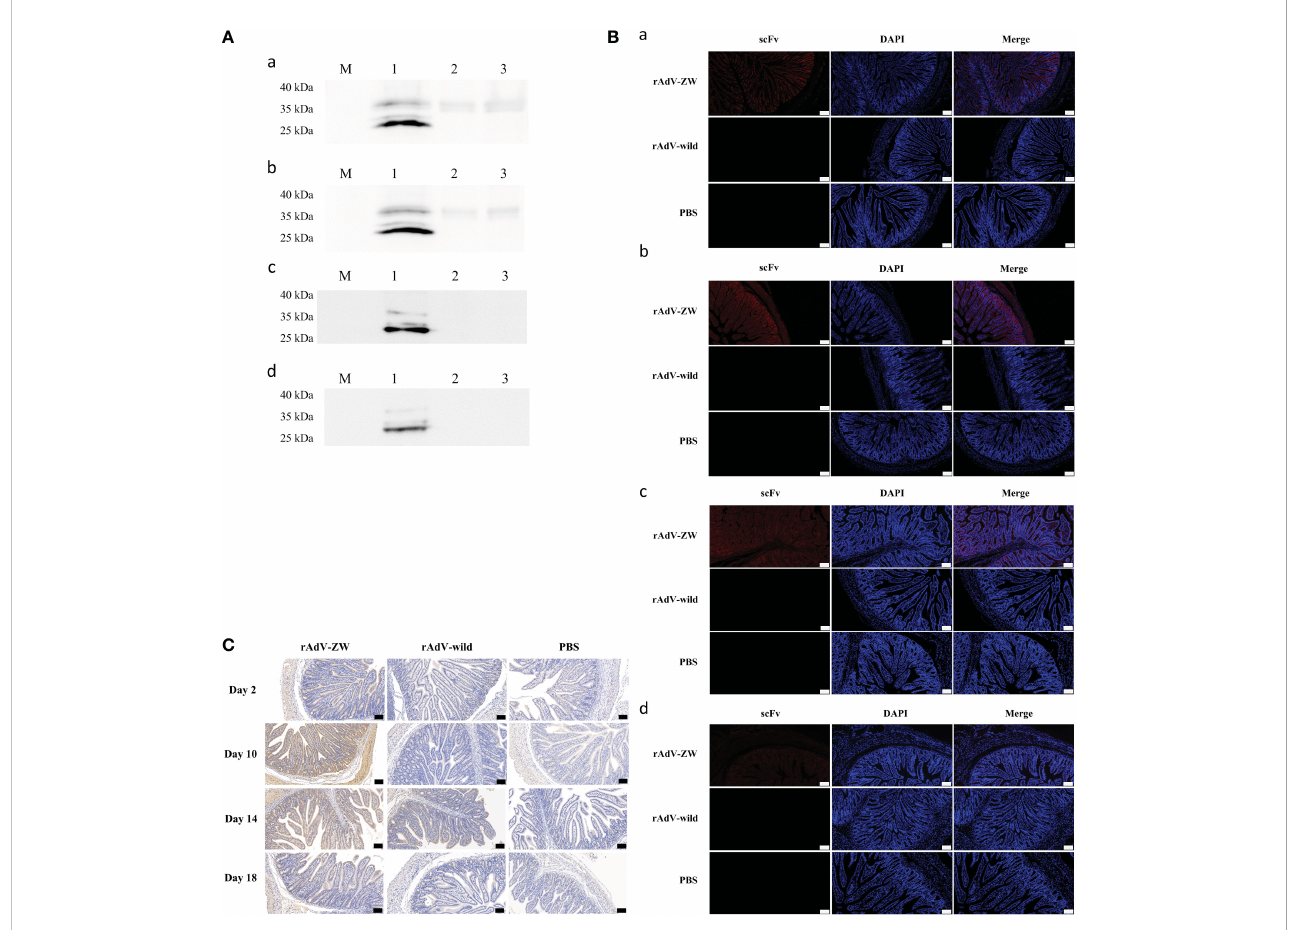
FIGURE 4 Jejunal expression of four scFvs. After rAdV-ZW, rAdV-wild-type or PBS oral administration, jejunums were collected on days 2 ( Aa , Ba ), 10 ( Ab , Bb ), 14 ( Ac , Bc ), and 18 ( Ad , Bd ). (A) Western blotting of scFv expression in jejunum tissue showing several bands at approximately 30-35 kDa. Lanes 1 – 3, jejunum tissue lysate from piglets administrated rAdV-ZW (lane 1), rAdV-wild-type (lane 2), and PBS (lane 3). (B) Immuno fl uorescence analysis showing scFv expression in jejunum tissue. Jejunum paraf fi n sections were incubated with a primary mouse monoclonal anti-HA antibody to detect HA-tagged scFvs, and then stained with DAPI to observe nuclei. Red fl uorescence represents scFvs and blue represents nuclei. Scale bar = 100 m m. (C) Immunohistochemical jejunum tissue staining to analyze scFv expression. Brown staining indicates scFvs and blue represents hematoxylin-stained nuclei. Scale bar = 100 m